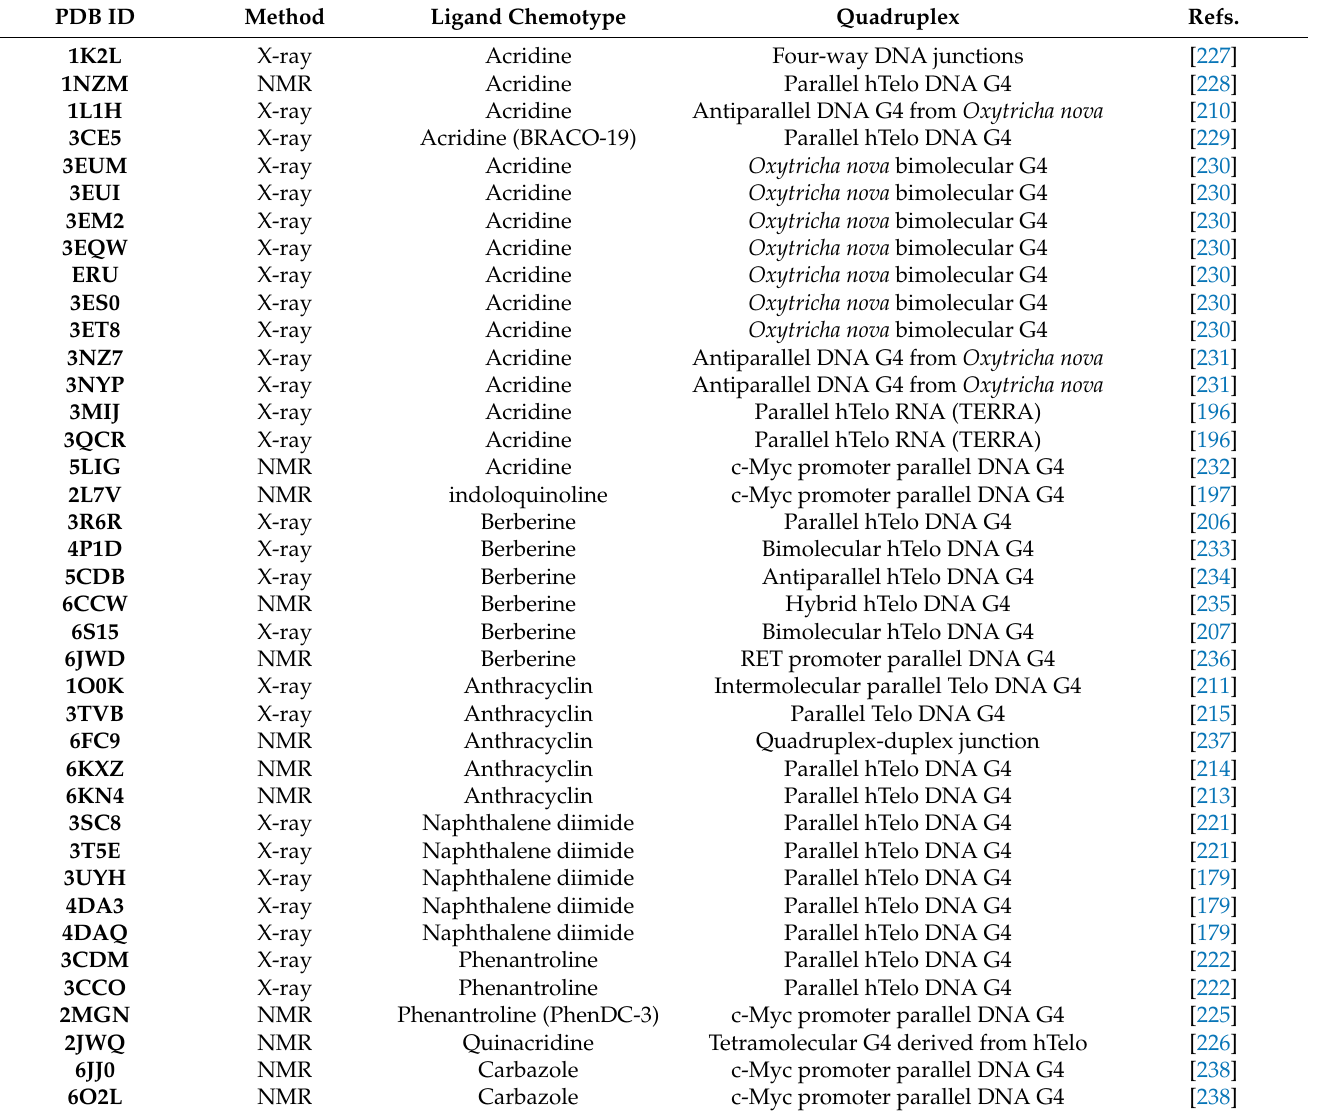
Table 4. Summary table with some reference complex structures of quadruplexes with fused aromatic polycyclic ligands available at the RCSB protein